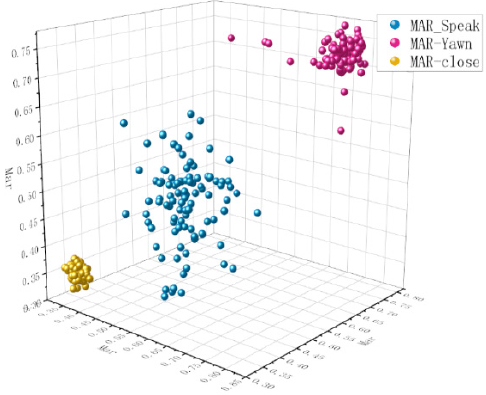
Figure 8. M AR values in different cases.